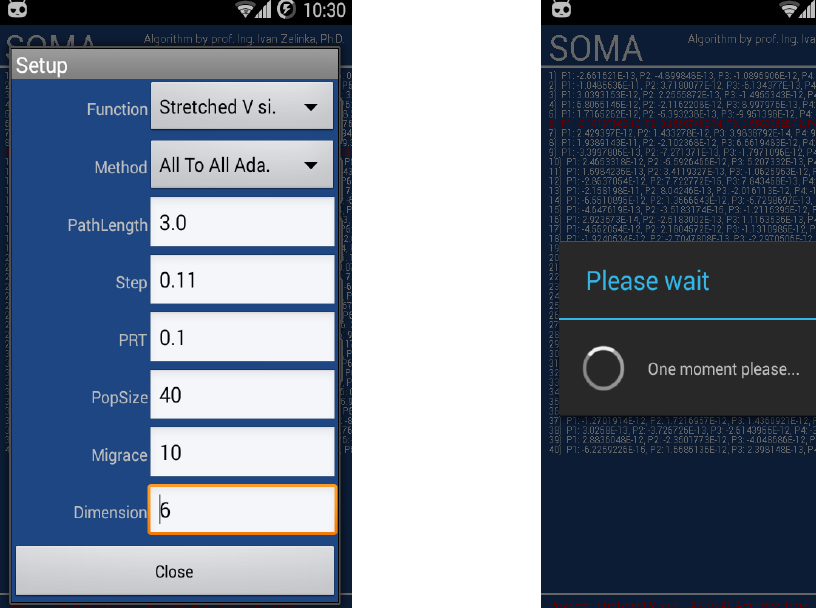
Fig. 3: App setup Source: Custom processing (cid:21) app screenshot